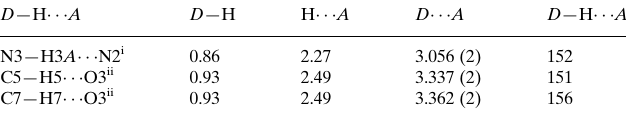
Hydrogen-bond geometry (A˚ , (cid:2)